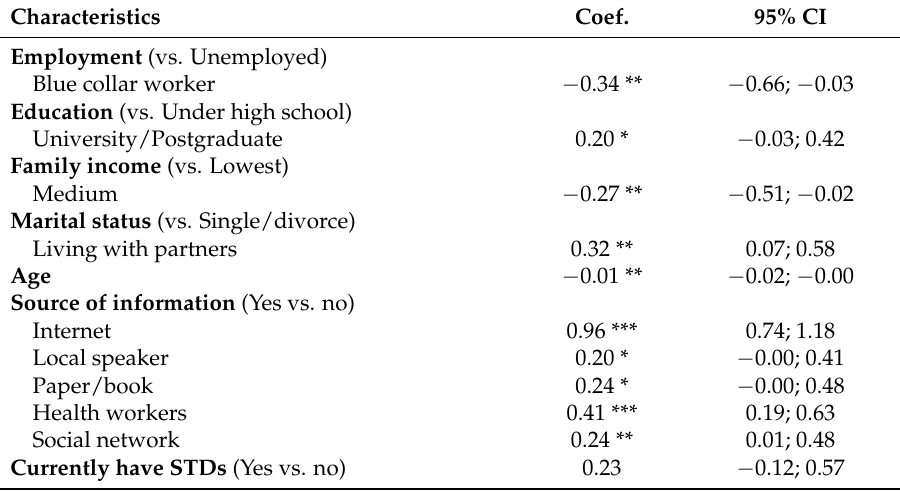
Table 4. Factors associated with participants’ knowledge of